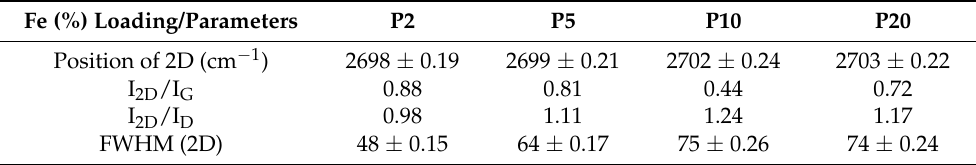
Table 2. Raman spectroscopy results of P2% to P20% Fe-loaded